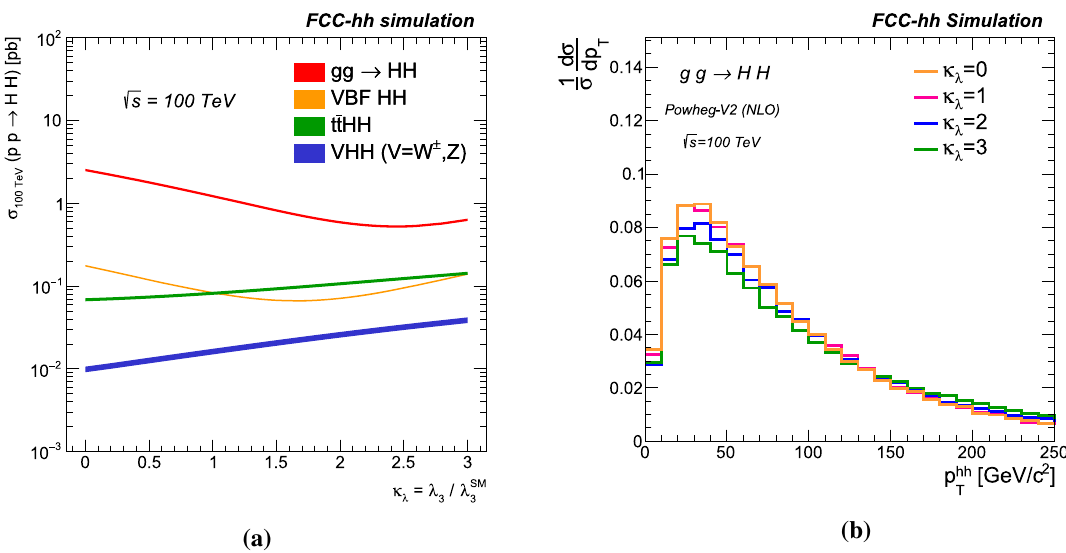
Fig. 2 a Cross section of the ggHH, VBF HH, t ¯ tHH, and VHH processes as a function of κ λ = λ 3 /λ SM the HH system in ggHH NLO events after parton-shower merging for κ λ = 0, κ λ = 1, κ λ = 2 and κ λ =